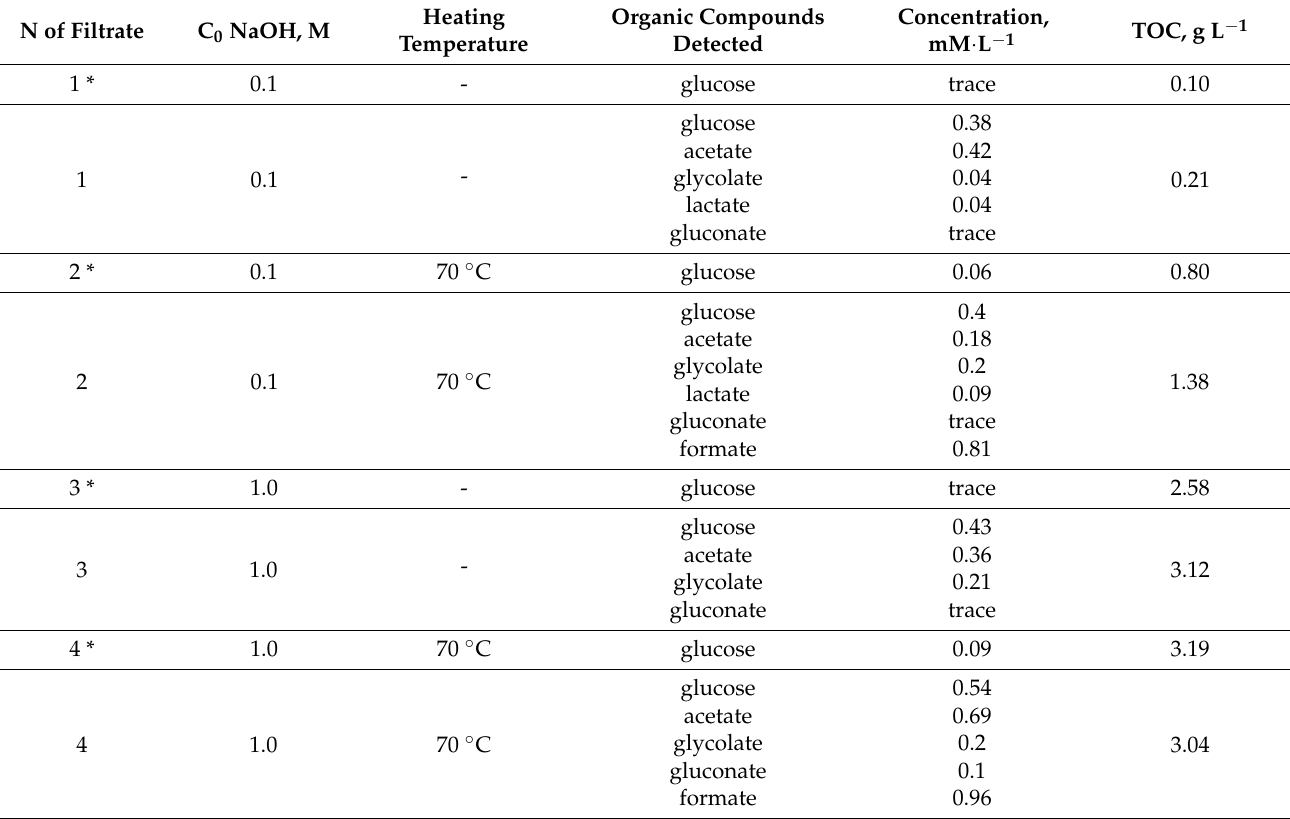
Table 2. The results of aqueous phase analysis. C 0 (corn starch) = 5 g · L − 1 , C(cat) = 2.5 g · L − 1 , V = 20 mL. TOC—total organic carbon. N of